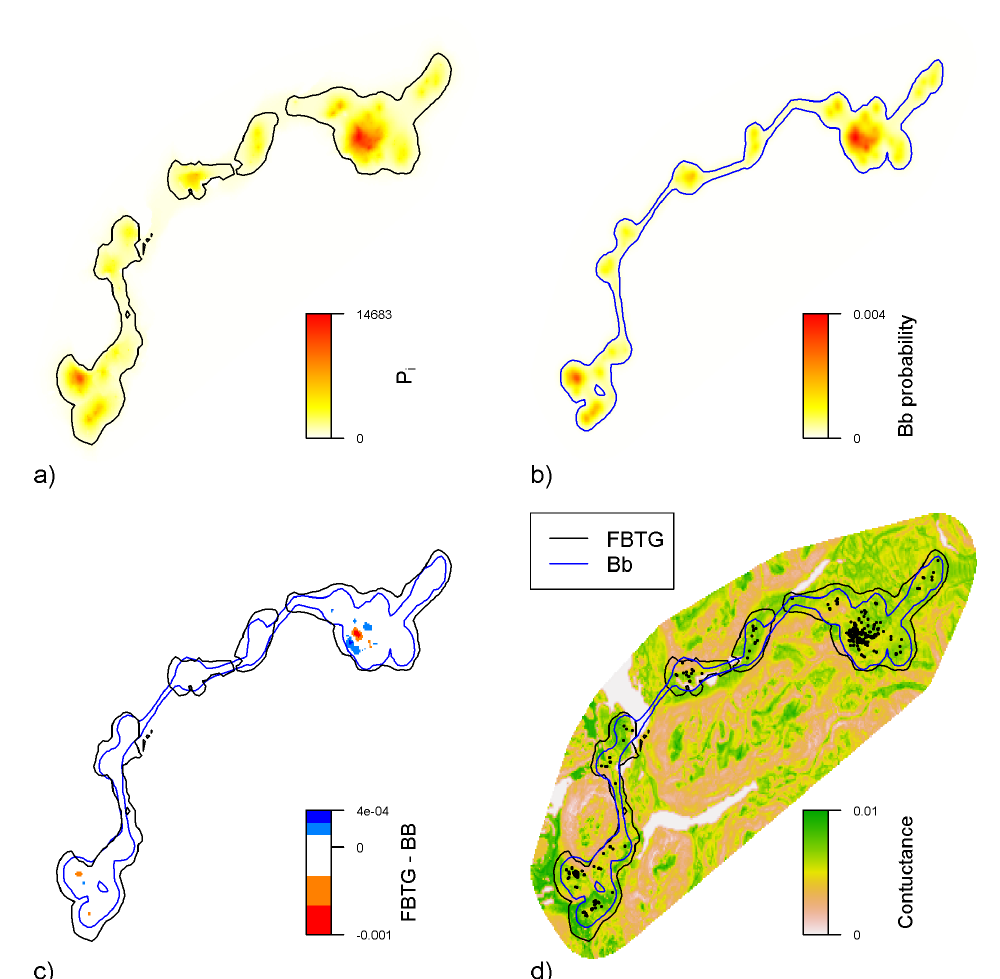
Figure 10: Utilization distributions for a single caribou during the summer (July-August) of the year 2000 using the a) field-based time geography, and b) Brownian bridge methods, along with the 99% volume contour home ranges; c) the difference between the field-based time geography and Brownian bridge methods, and d) the home range polygons overlaid on the conductance surface of the study area with the caribou relocation